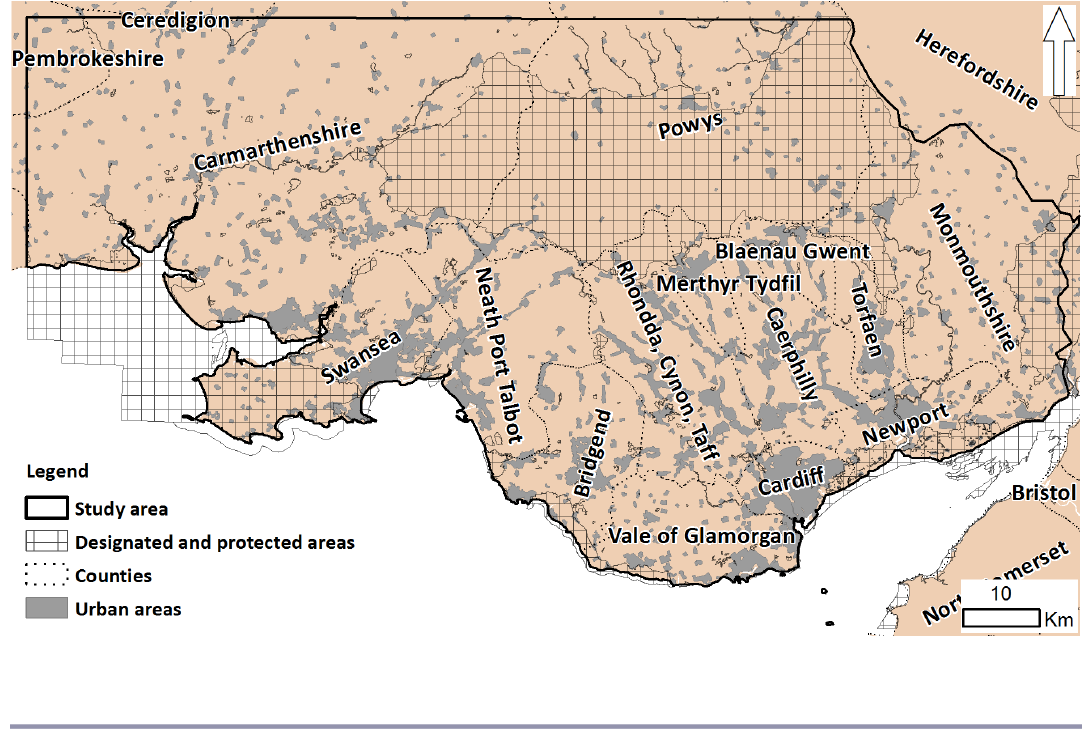
Fig. 2. Detailed map of the South Wales study area, indicating designated and protected areas and urban